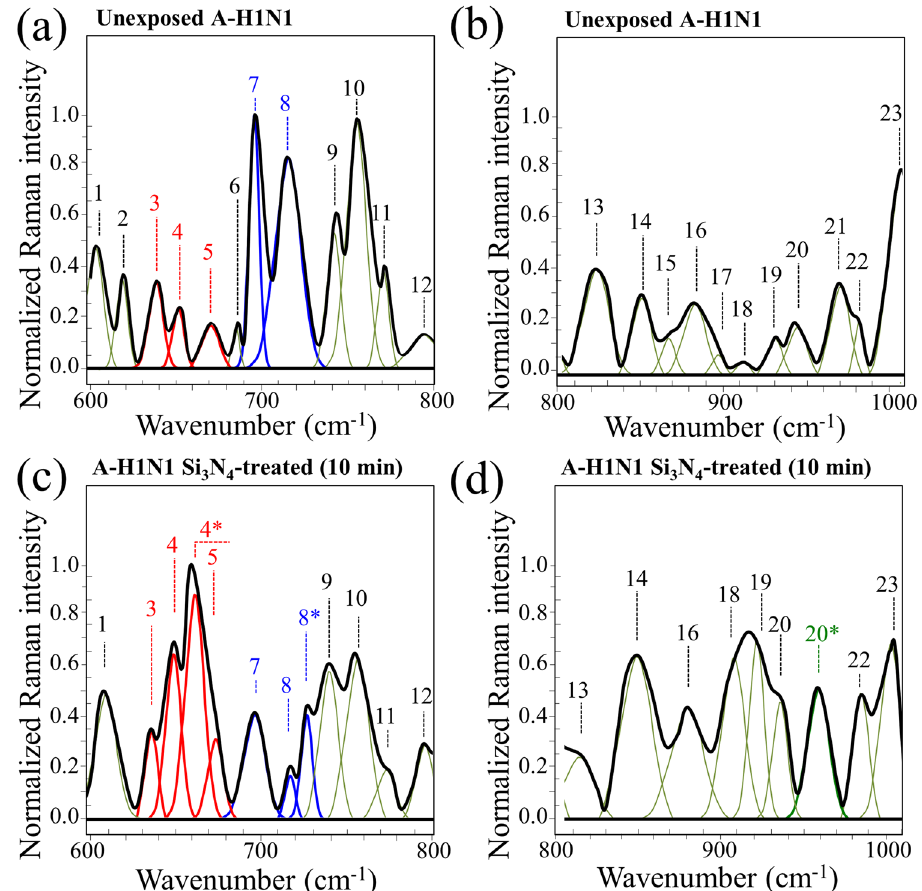
Figure 8. Deconvoluted Raman spectra in the frequency ranges 600–800 cm −1 ( a ) and 800–1000 cm −1 ( b ), as collected in situ on a sample of pristine Influenza A H1N1 virus; in ( c ) and ( d ), Raman spectra are given in the same frequency intervals, respectively, as collected on virions exposed for 10 min to a 15 wt.% Si 3 N 4 dispersion in aqueous solution. The deconvoluted Raman bands, labeled from 1 to 24, are listed according to their frequency at maximum and classified with respect to their vibrational origins in Tables S-I and S-II of the Supplementary